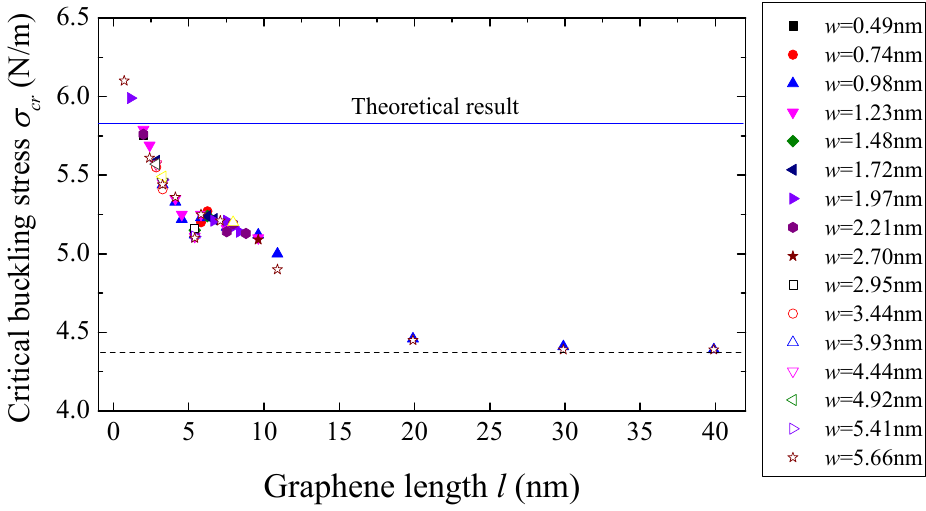
Figure 7. The critical buckling stress versus length of the monolayer graphene sheets with different sizes on a graphene substrate.